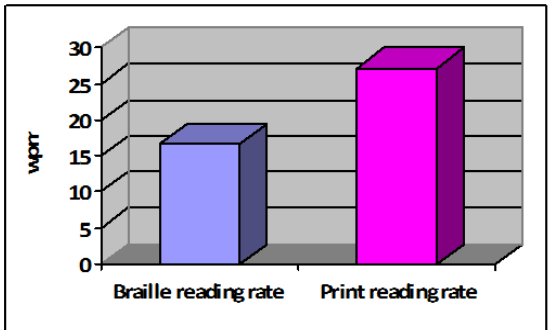
Figure 1. Braille and print reading rate